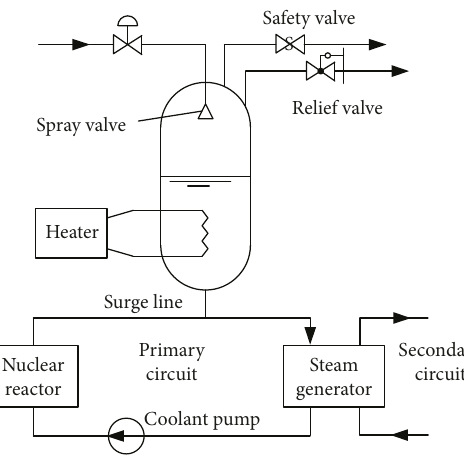
Figure 2: Structure of the electrothermal